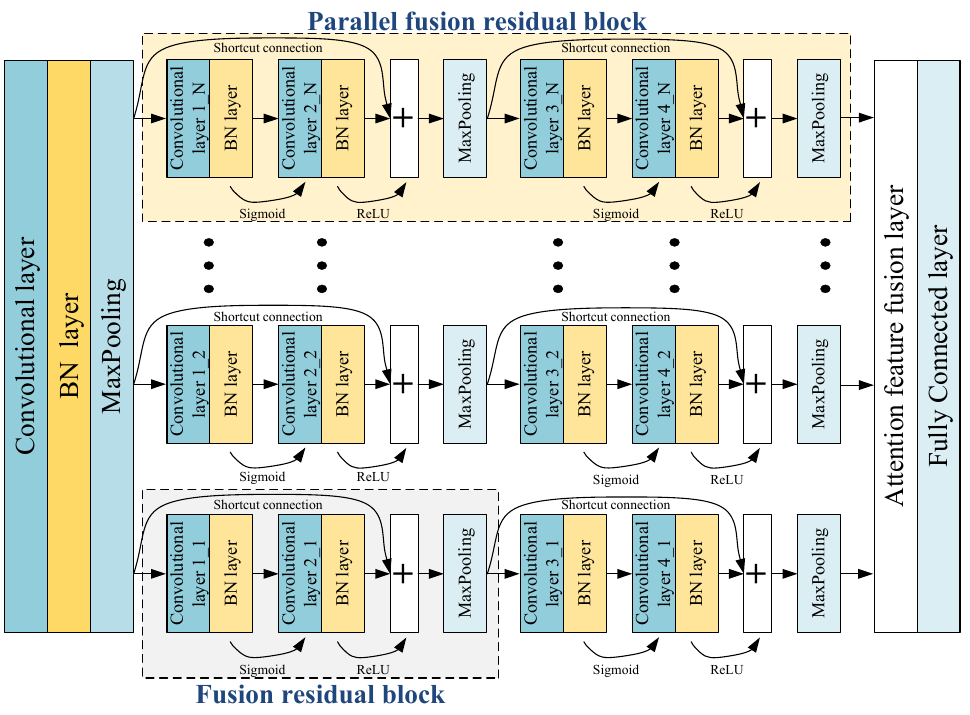
Figure 1. Parallel deep learning framework.